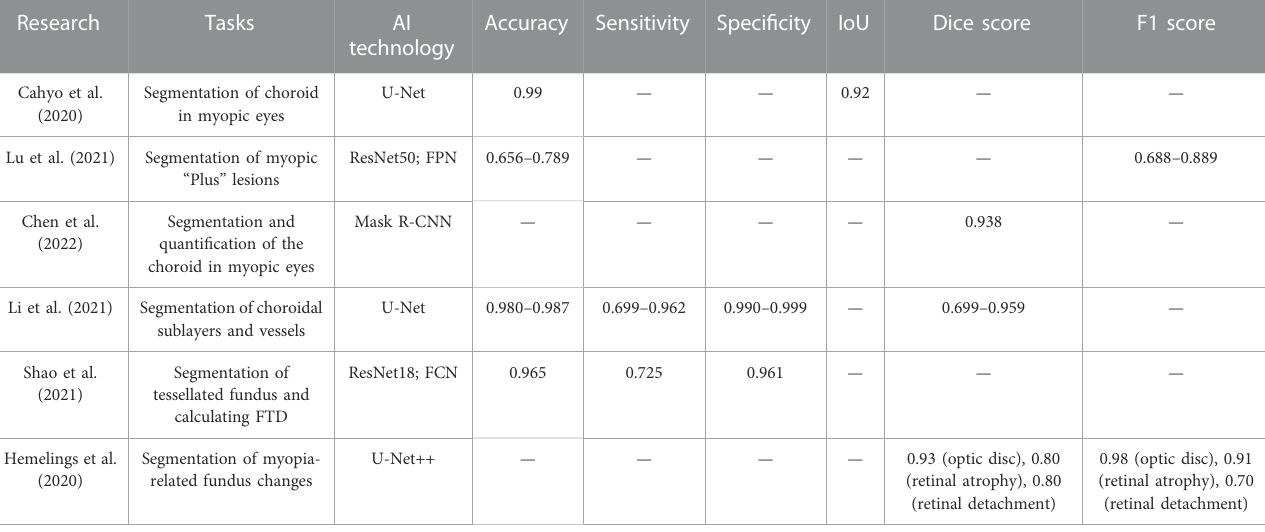
TABLE 3 Summary of DL methods for segmentation tasks in myopia.